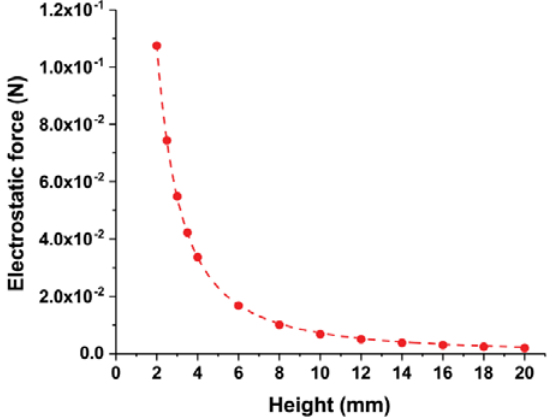
Figure 9. Electrostatic force changes due variation in the height of the X-shaped actuator.